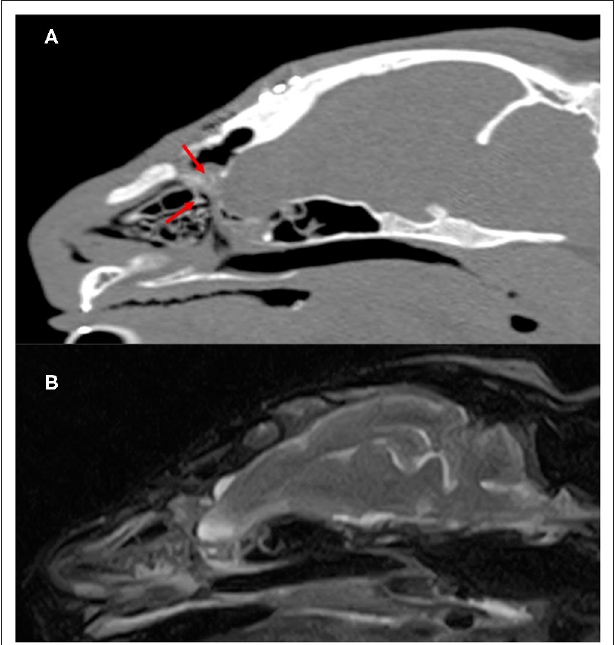
FIGURE 4 | Postoperatve CT and MR images of the cranium and brain 7 months after surgery. Parasagittal CT images (A) showed slightly superabsorbent structures separate cranial cavity and nasal cavity (red arrow). On parasagittal T2-weighted MR images (B) , there is no apparent departure of the brain into the nasal